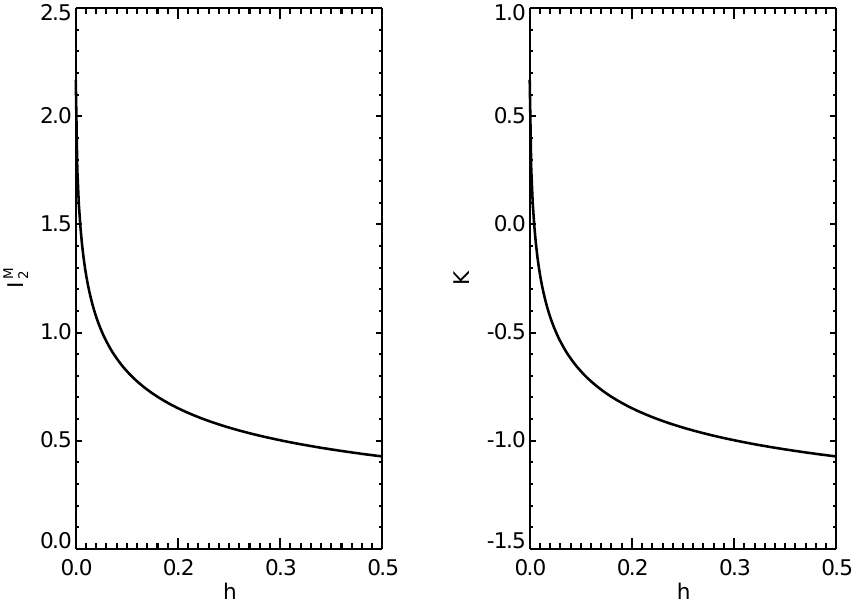
Fig. 2. The plot of I M (left) and K (right) as the function of the wave amplitude h . The plasma parameters are: T ⊥ /T || = 2 and β ⊥ = 2. 2